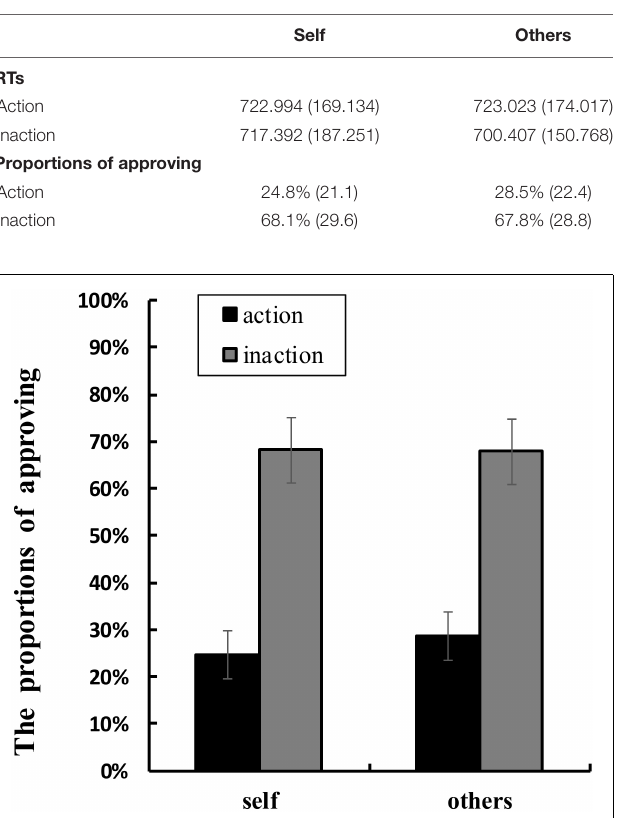
the controlled cognitive process supporting moral